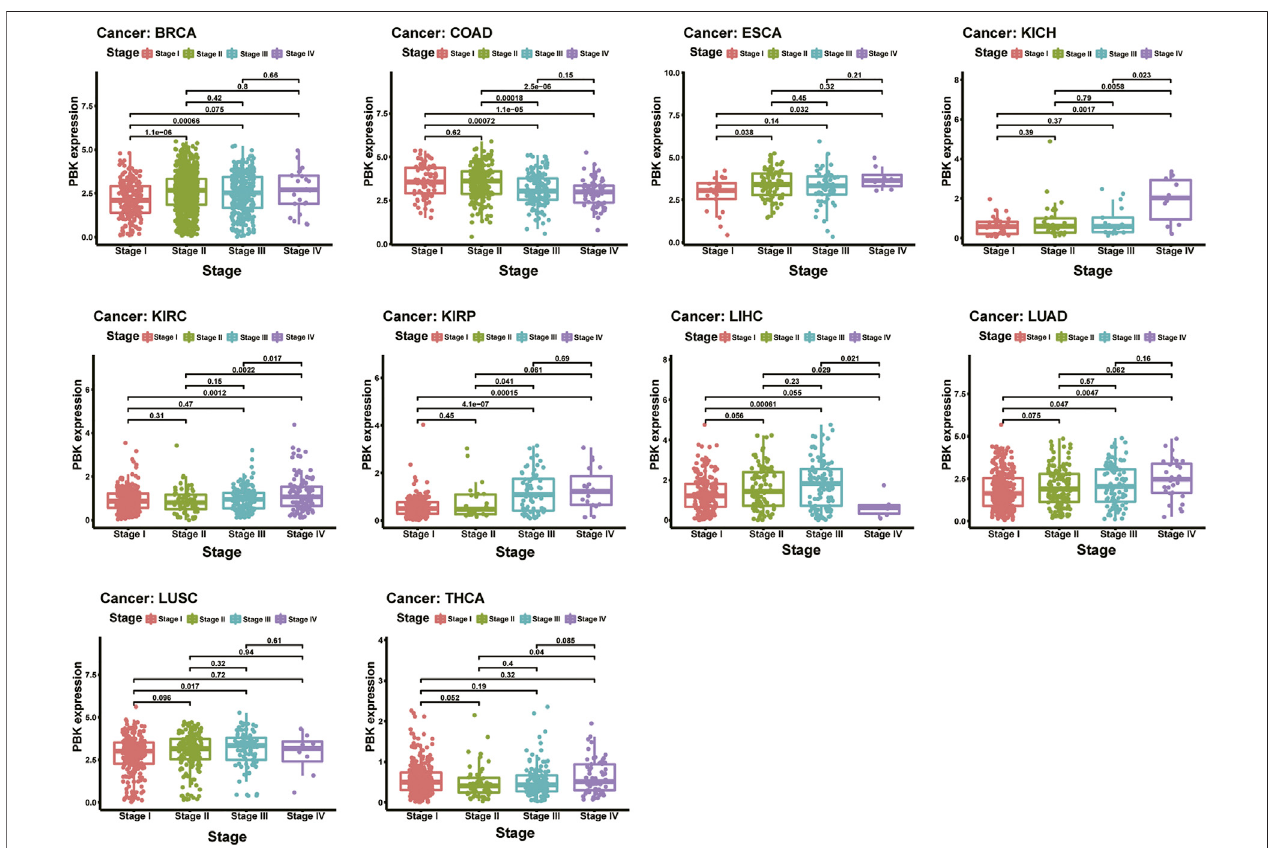
FIGURE 2 | | Relationship of PBK expression with patients ’ OS. Forest plots of hazard ratios of PBK in 33 cancer types and Kaplan – Meier OS curves for patients strati fi ed by different expression levels of PBK in eight cancer